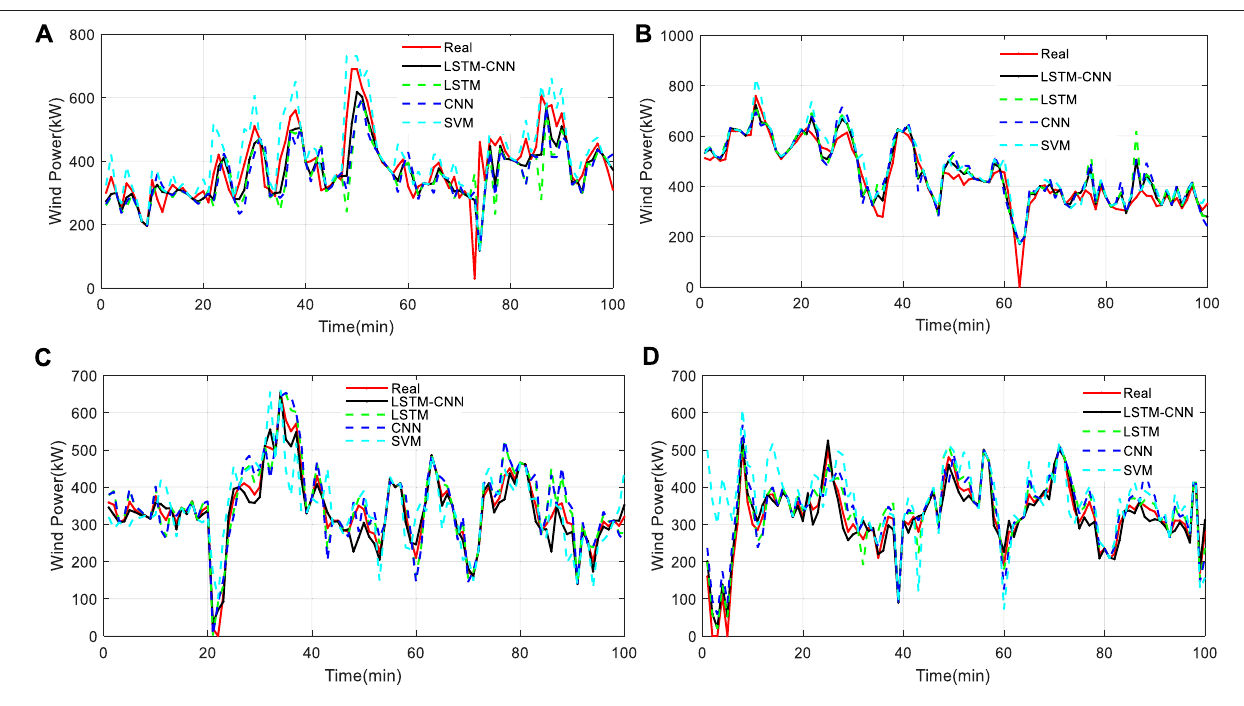
FIGURE 3 | Two-hour power prediction results for wind turbines: (A) #17; (B) #19; (C) #23; (D) #25.